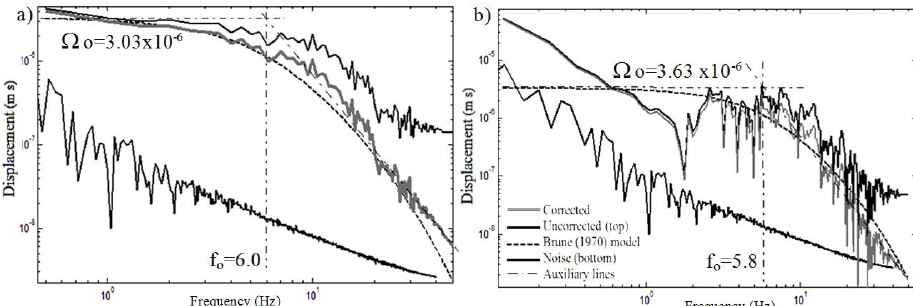
Fig. 6. (a) P-wave and (b) S-wave displacement spectrums from the largest earthquake in Peñamiller, corrected and uncorrected for atten- uation, are shown. Spectral shape according to the Brune (1970) model and noise spectrum are also shown. The corner frequency f o and spectral flat level (cid:127)o are